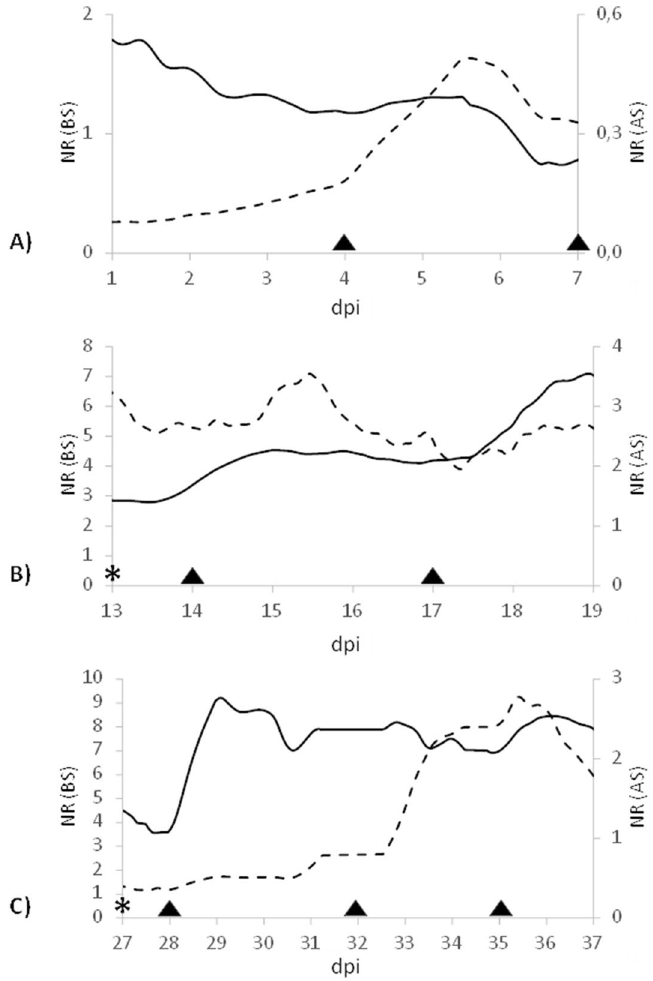
Figure 3. Normalized Sensor Response (NR) of the apical sensor (AS, solid line) and the basal sensor (BS, dashed line) in three different intervals of the experiments: ( A ) initial phase (1–7 days post sensor installation, dpi); ( B ) median phase (13–19 dpi); ( C ) final phase (27–37 dpi). Solid triangles indicate the application of saline treatments. The asterisk indicates the maintenance of the sensor.